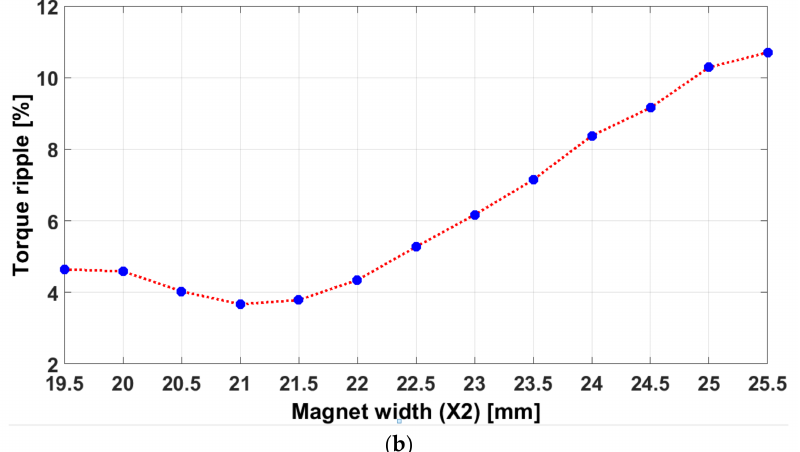
Figure 5. Impact of the side magnet width variation on: ( a ) the average torque; ( b ) the torque ripple.